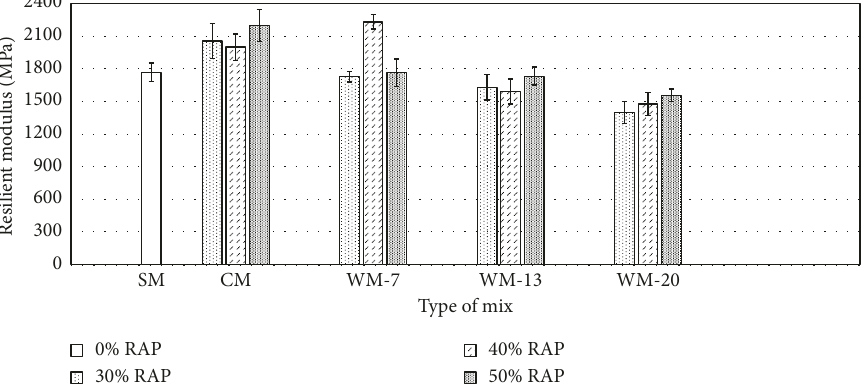
Figure 4: Comparison of resilient modulus for mixes with no RAP and rejuvenated by CR with mixes rejuvenated by